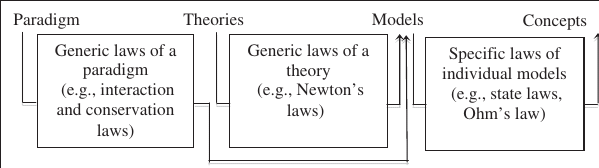
FIG. 4. Schematic of conceptual organization in a scientific paradigm as proposed by Halloun, reprinted with permission from I. A. Halloun, Modeling Theory in Science Education (Kluwer, Dordrecht, 2004), p.